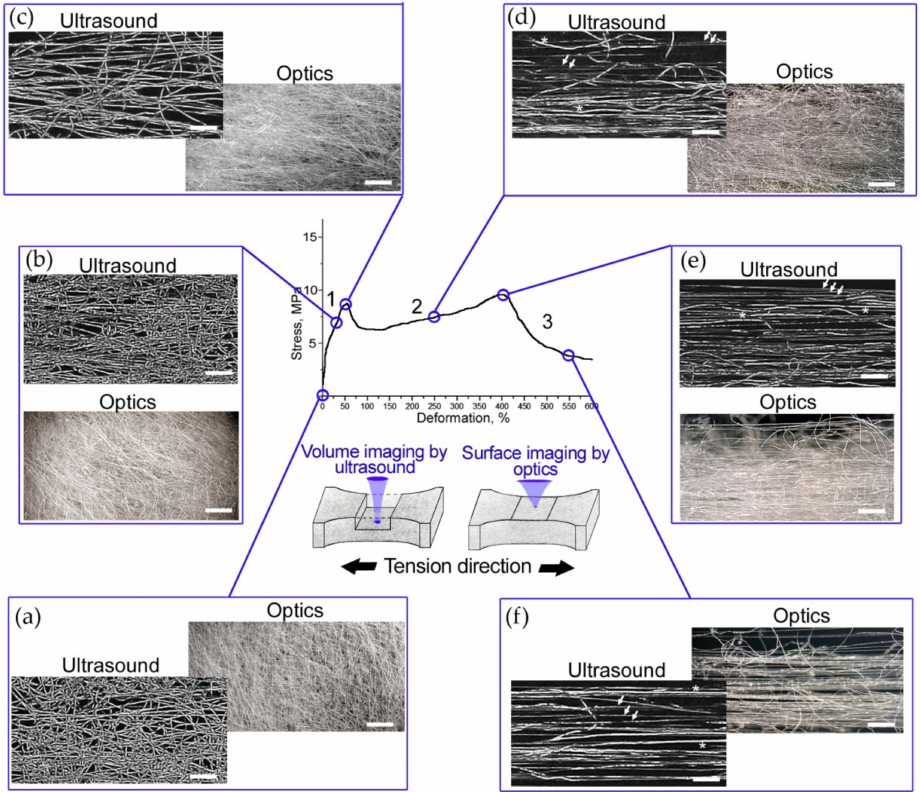
Figure 4. Step-by-step imaging of the test PLLA sample using light and acoustic microscopy at deformations of ( a ) 0, ( b ) 30, ( c ) 50, ( d ) 250, ( e ) 400, and ( f ) 550%. Microphotographs were obtained at a magnification of × 50. They show integral structures seen from the top surface of the nonwoven scaffold. Ultrasound images were obtained at the central depth of the test sample. They depict only the fibers that are part of a narrow volume with a thickness of 50 µ m in the bulk. ( a – c ) Both types of images show fibers of the original diameter only at strain up to 50%. The ultrasound images ( d – f ) show an example of thinned elongated fibers, and asterisks indicate fibers of initial diameters. The scale bar is 500 µ